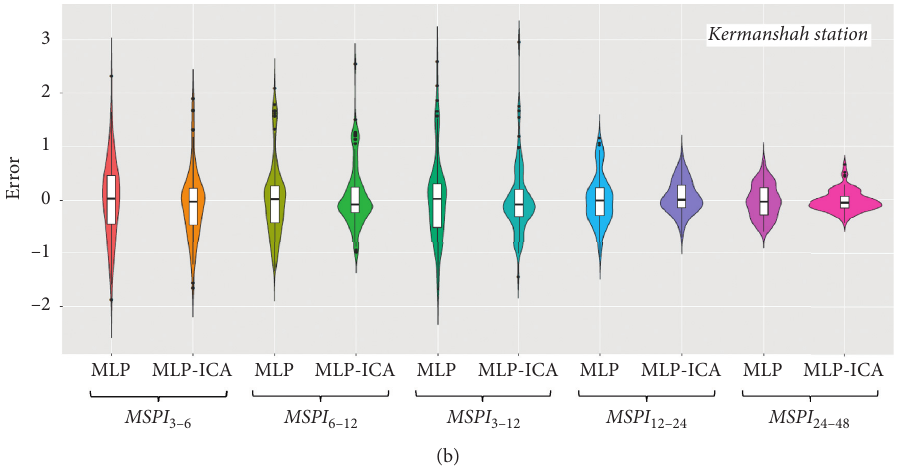
Figure 8: Violin plots of the error distributions in the test